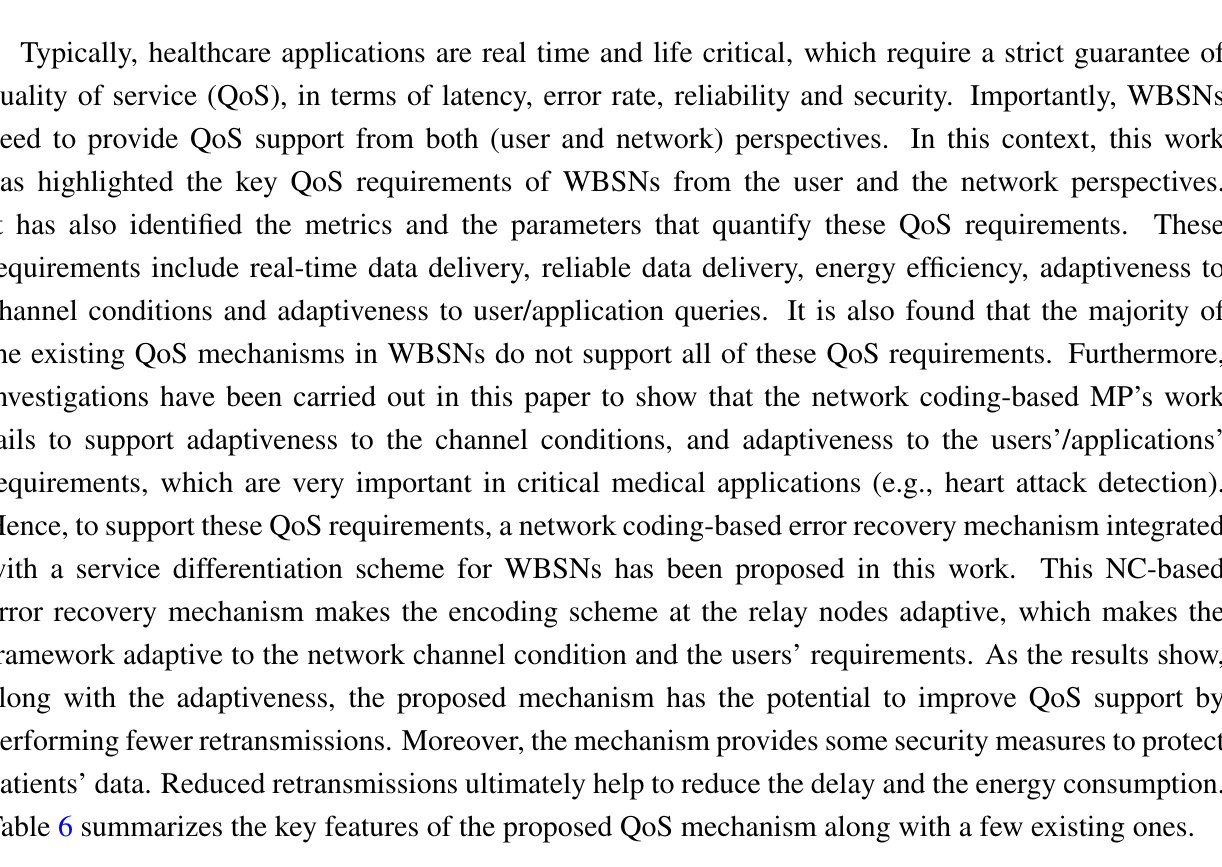
Table 6. QoS requirements addressed by the proposed mechanism. U-MAC, urgency-based MAC; DQBAN, distributed queuing body area